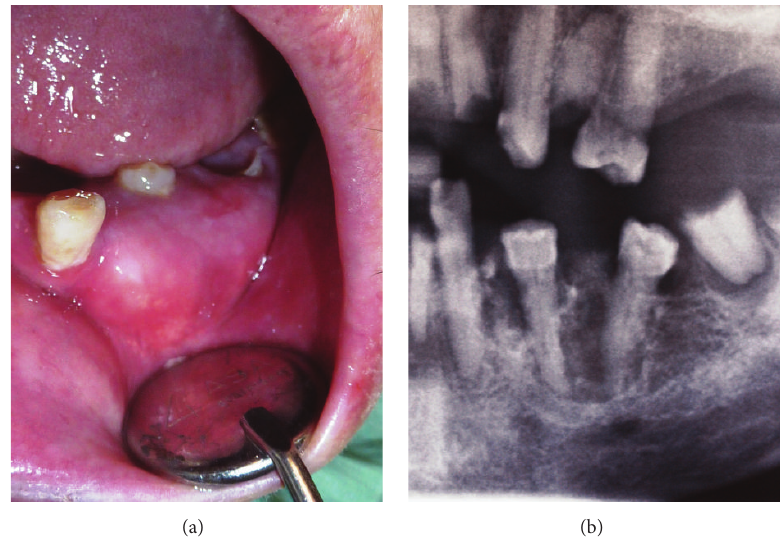
Figure 1: (a) Intraoral view of a left mandible enlargement with displacement and submersion of involved teeth. (b) Panoramic radiographic image (partial view) showing a multilocular radiolucent lesion with calcified foci.